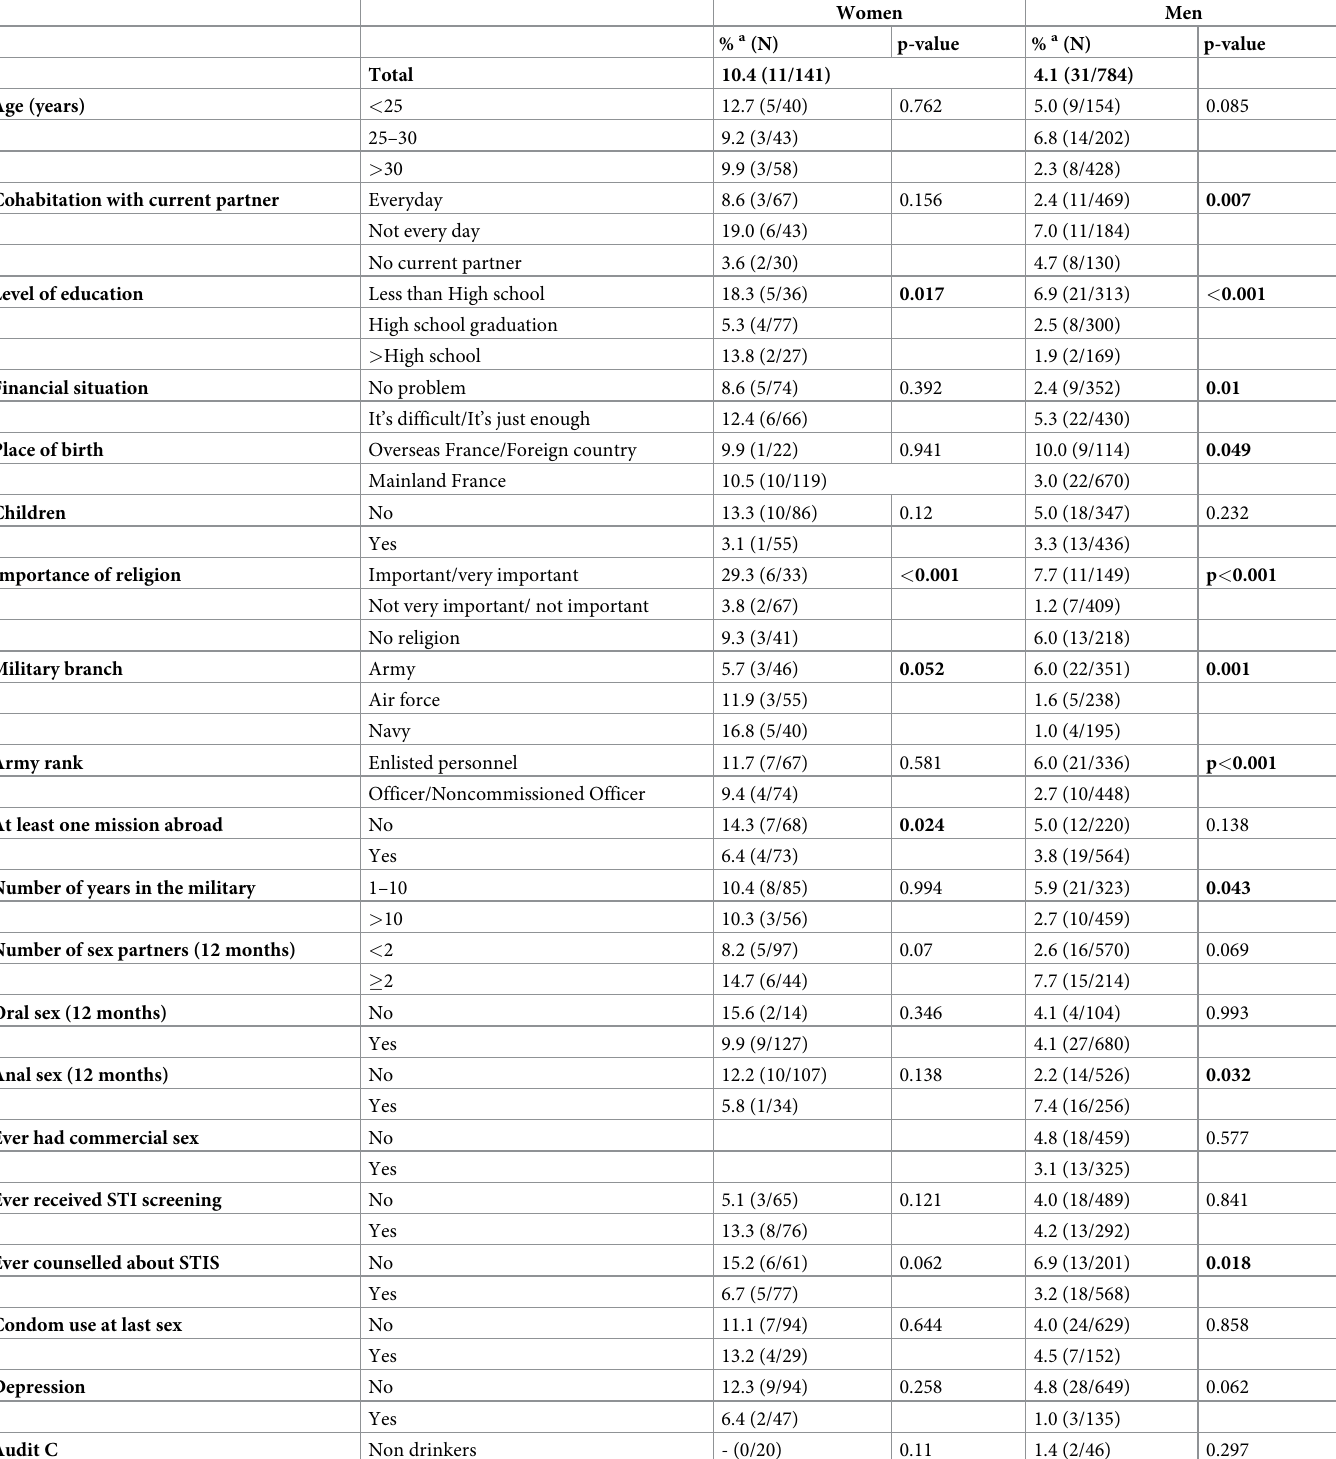
Table 4. Factors associated with biologically confirmed STIs (diagnosed STIs)- results of univariate logistic regression among French servicewomen (n = 141) and servicemen (n = 784), COSEMIL